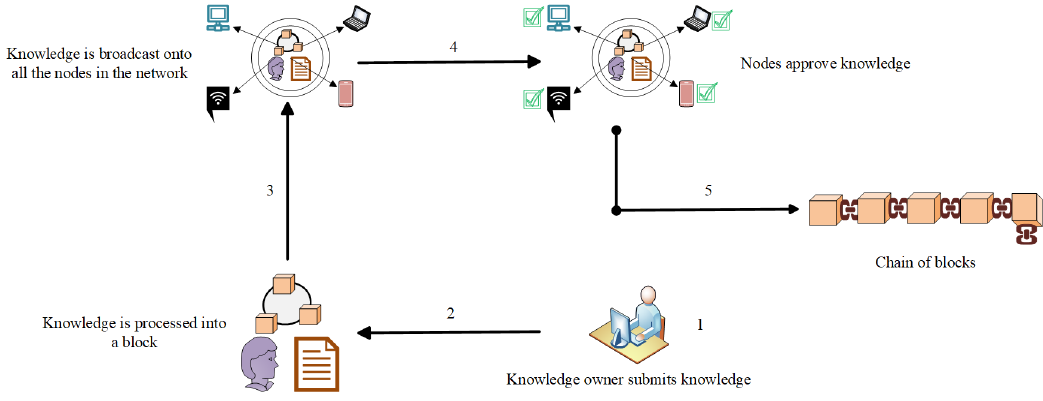
Figure 2. Creation of a knowledge